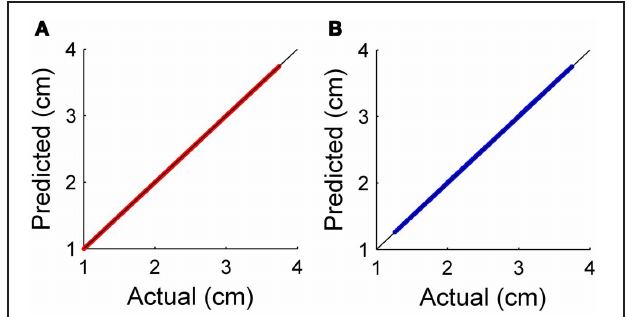
FIGURE 5 | (A) Relationship between predicted and actual radial distance for prediction using local object slope (B) Relationship between predicted and actual radial distance for prediction using local object